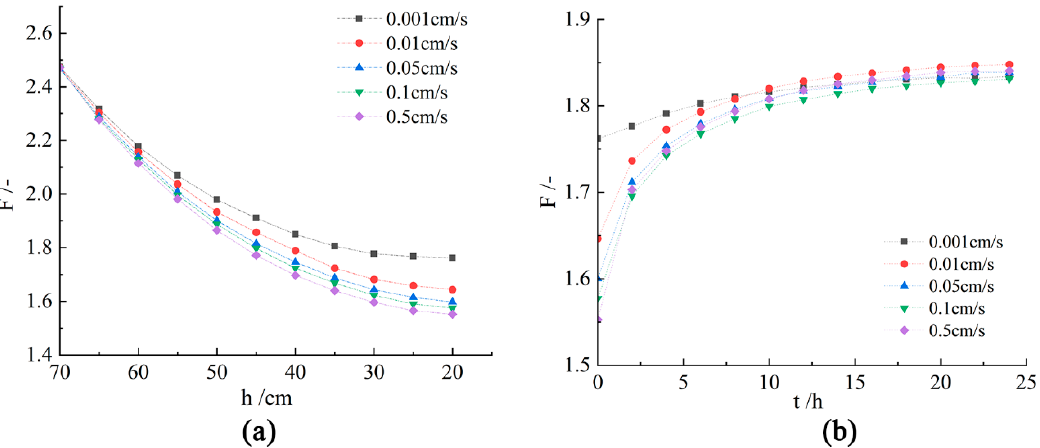
Figure 9. Variation of the safety factor of silt slope with different influence conditions under differ- ent water levels: ( a ) falling speed; ( b ) time.